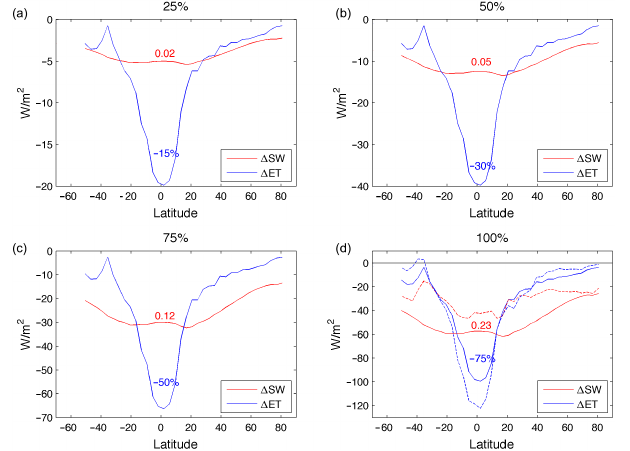
Figure 6. The latitudinal pattern of (cid:49) SW and (cid:49) ET calculated by multiplying their background climate values with different rates for albedo (red number, from 0.02 in (a) to 0.23 in d ) and ET changes (blue number, from − 15% in (a) to − 75% in d ). In (d) , dashed lines are simulated changes from global deforestation for compari- son with the calculated changes (solid